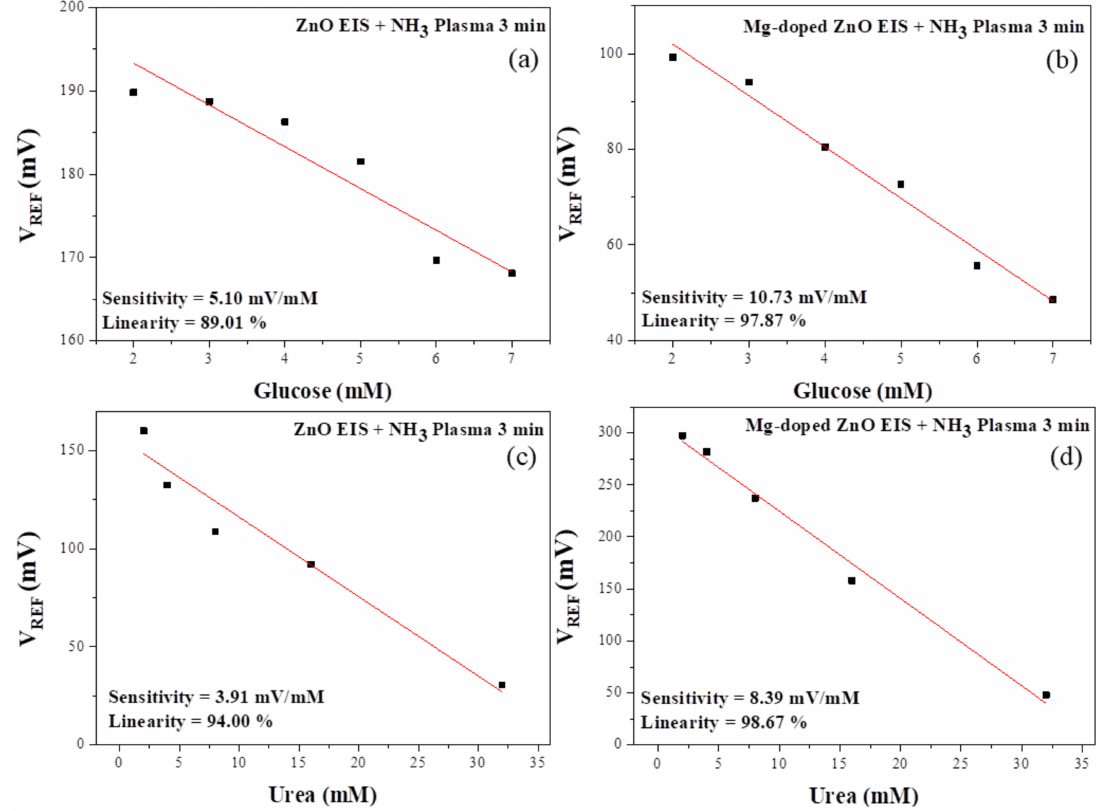
Figure 8. The ( a , b ) pGlucose / ( c , d ) pUrea responses of EIS structures consisting of enzyme-immobilized ZO and MZO treated with NH 3 plasma for 3 min, using the covalent bonding